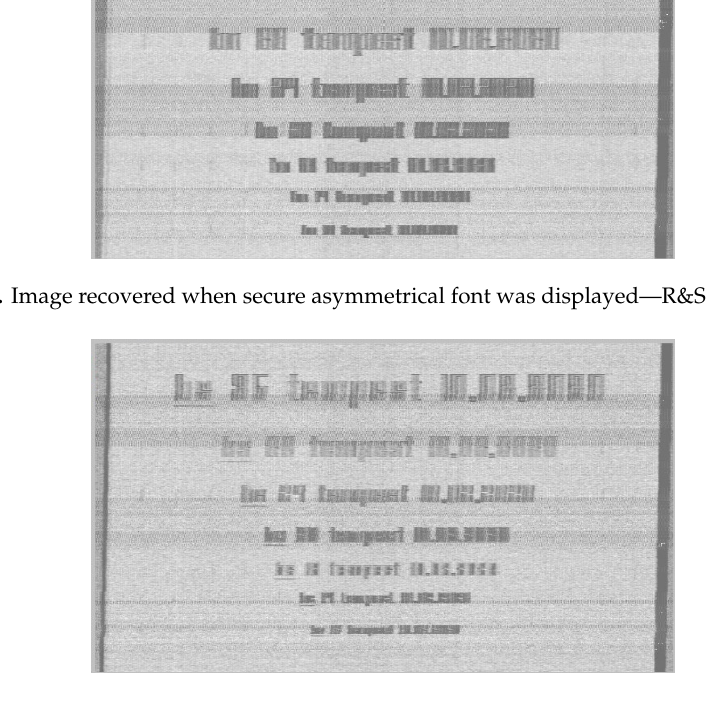
Figure 10. Image recovered with Font 28 with blank spaces: secure asymmetrical and secure symmetrical—R&S FSWT receiver. Figure 11. Image recovered with Times New Roman font—R&S FSWT receiver. In Figures 10 and 11, we have illustrated the recovery image results obtained by using the FSWT receiver produced by the Rohde&Schwarz Company, which is the latest TEMPEST receiver model released on the market by the German company. This equipment comes with the raster module built in. It is true that, when using the FSET22 receiver, we allocated about 30 minutes to find the optimal video recovery parameters, while when using the FSWT receiver, we solved the same objective with